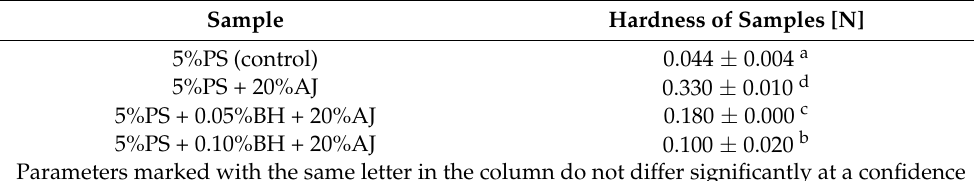
Table 4. Hardness of fruit gels with potato starch and buckwheat fiber. Sample